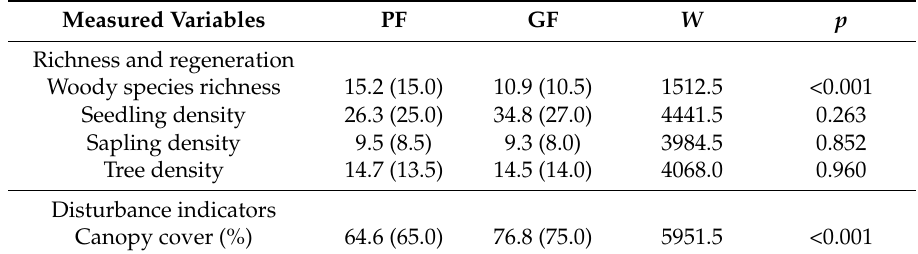
Table 2. Summary statistics for measured variables in forest plots (0.01 ha) inside protected forests (PF) and outside in government forests (GF). Numbers in parenthesis represent median values. W refers to the Wilcoxon W and is the lowest sum of ranks in Mann-Whitney U -test.